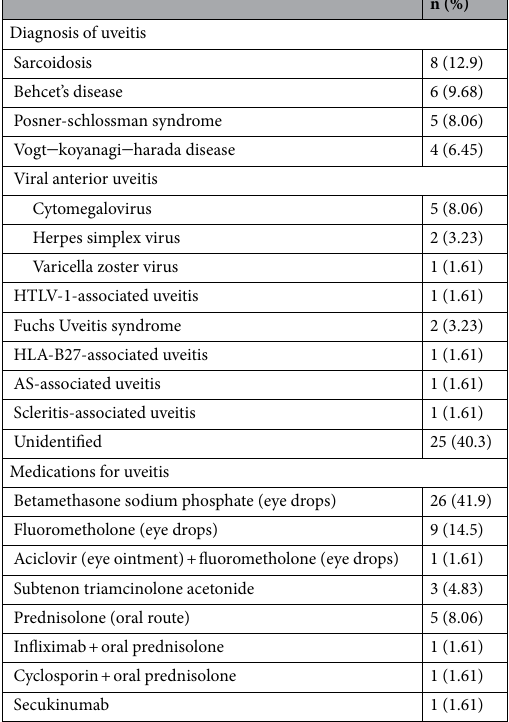
Table 2. Diagnosis of uveitis and medication for uveitis at baseline. AS, Ankylosing spondylitis; HTLV-1, human T-cell lymphotrophic virus type 1.